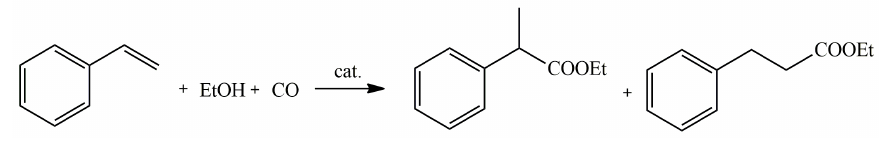
Figure 2. Hydroethoxycarbonylation of styrene.